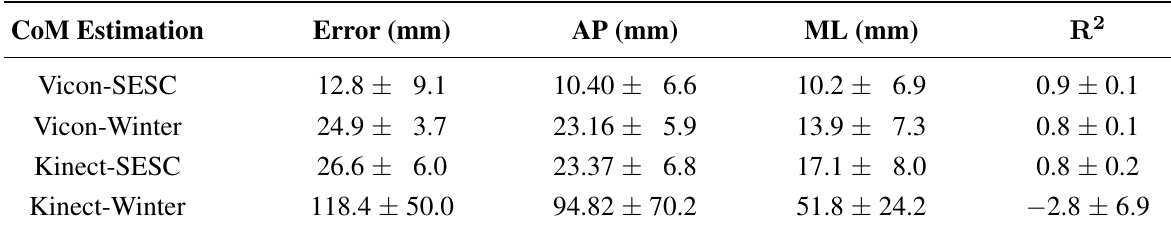
The root mean square error (rmse) for each CoM estimation method, in cross-validation for all seven subjects. The error is measured in the world reference frame, averaged for all subjects (cid:6) std. anterior-posterior (AP) and medio-lateral (ML) give the anterior-posterior and medio-lateral direction errors, respectively. R 2 is the coefficient of determination of the cross-validation